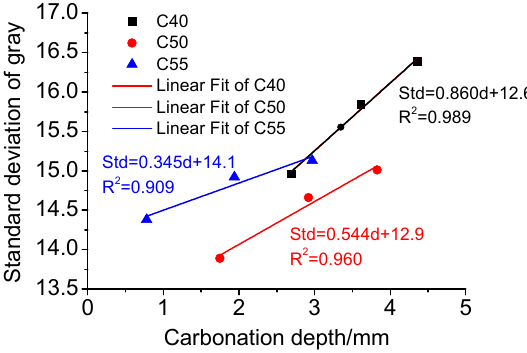
Figure 17. Relationship between standard deviation of gray and carbonation depth.